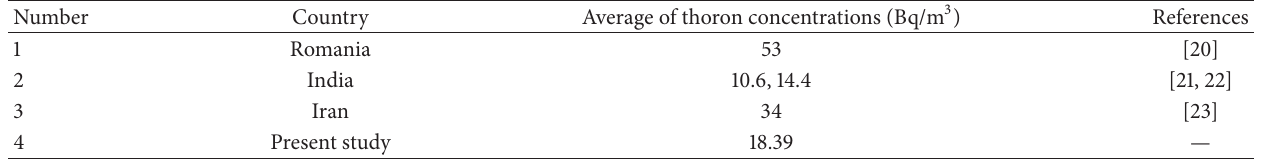
Table 4: Comparison of thoron concentration rate of the present study with other studies of the different